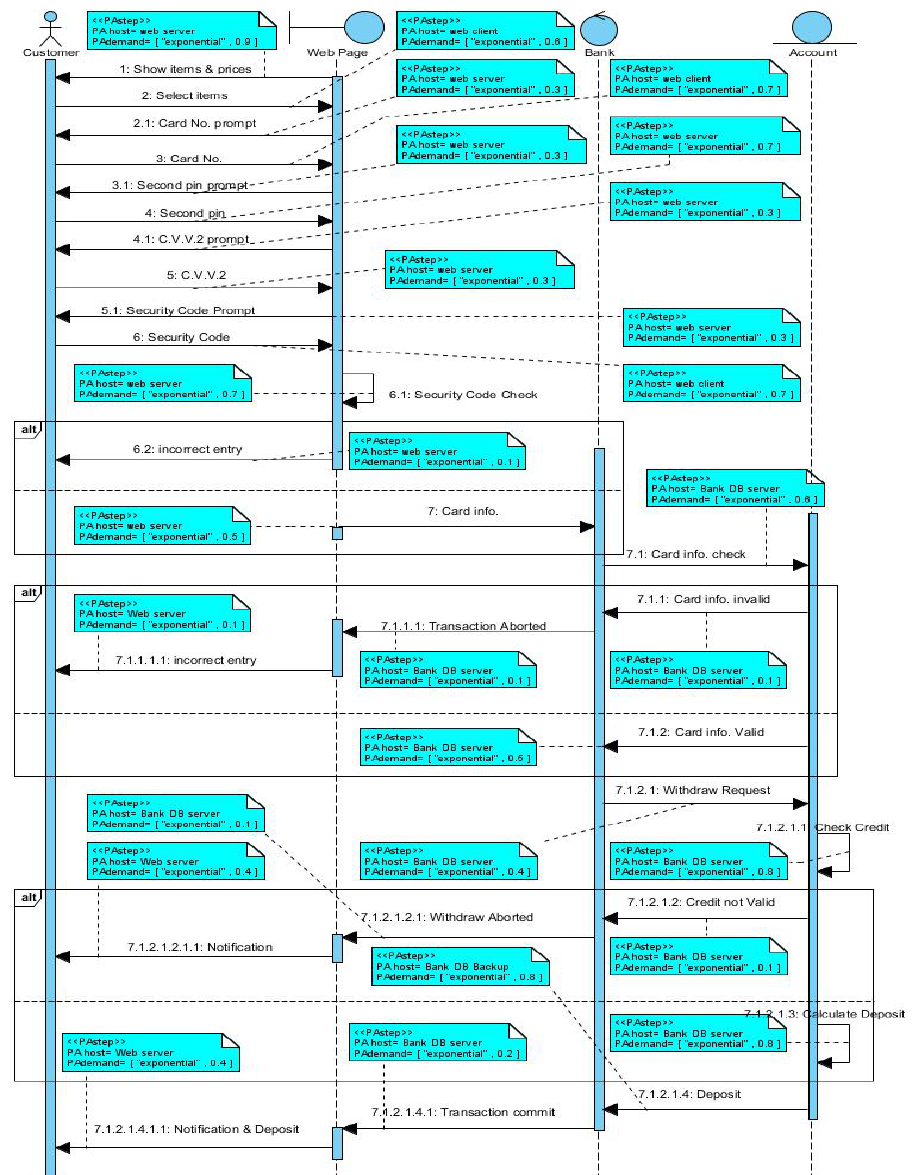
Fig. 4. The sequence diagram together with the efficiency information related to the online shopping system